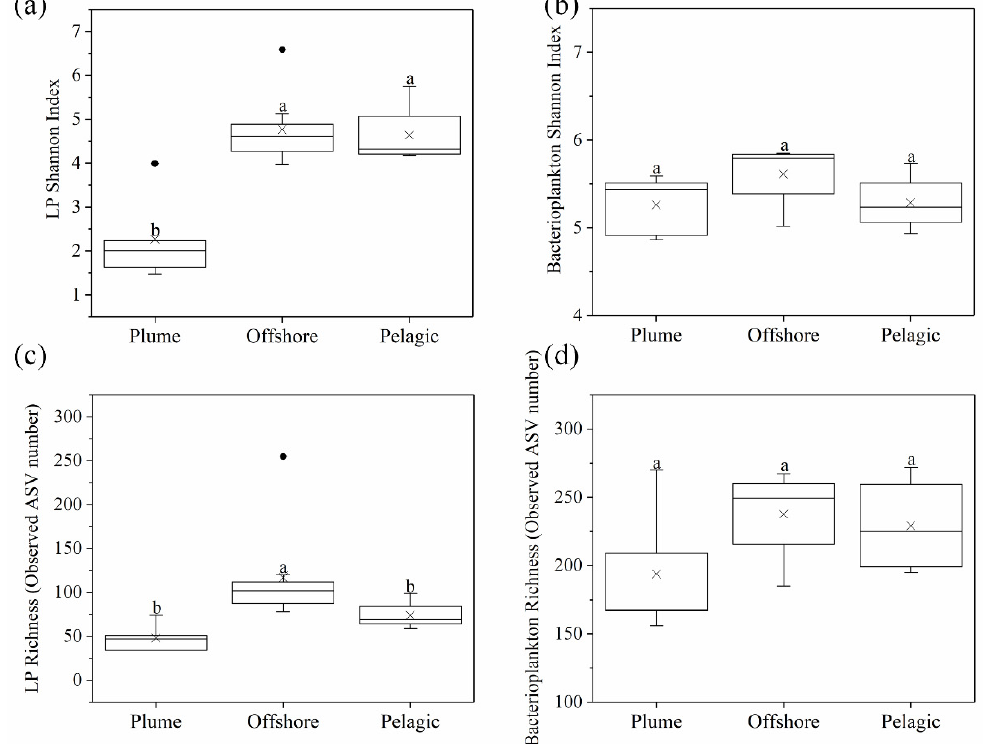
Figure 3. Alpha diversity index of LP and bacterioplankton across the salinity gradient: ( a ) LP Shannon index; ( b ) Bacterioplankton Shannon index; ( c ) LP Observed ASVs numbers; ( d ) Bacterioplankton Observed ASVs numbers. The multiplication sign inside each box represents the median value and the circles represent the outliers. Statistical significance was analyzed by Pairwise.wilcox test after the Kruskal–Wallis test. The significant differences are indicated by different letters.